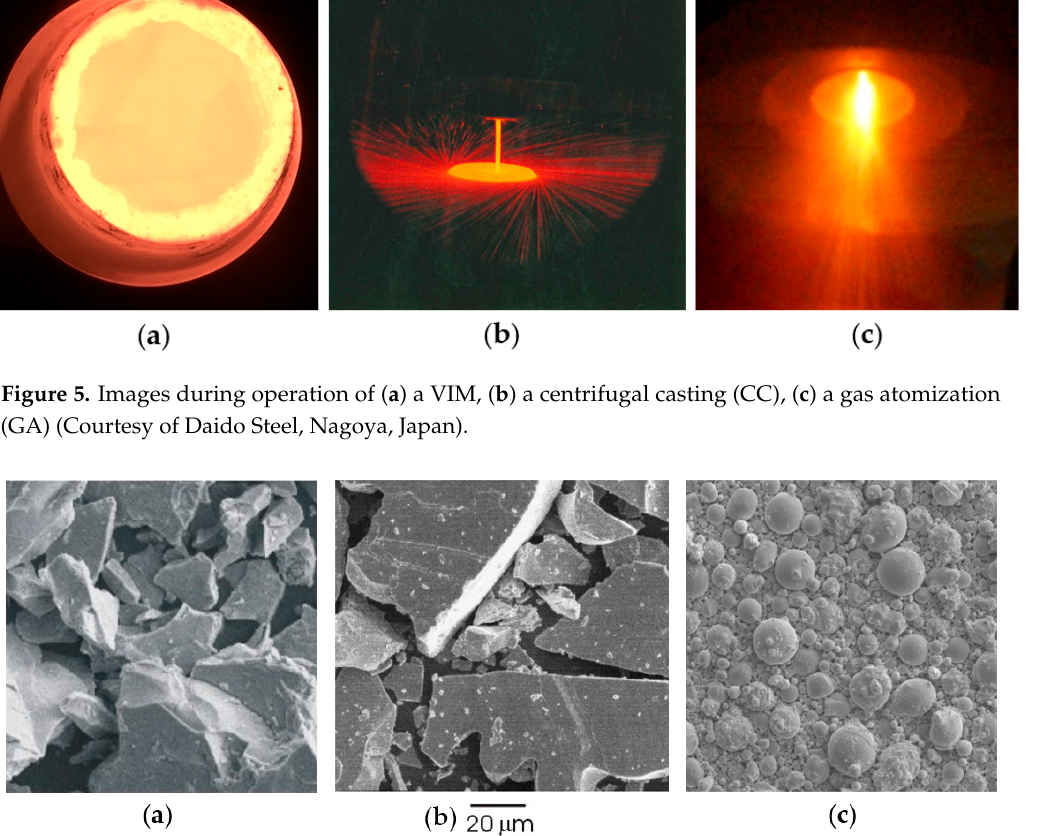
Figure 6. SEM micrographs showing top morphologies of alloys prepared by ( a ) VIM with a mechanical crush-and-grind, ( b ) melt-spinning (MS), and ( c ) GA processes.